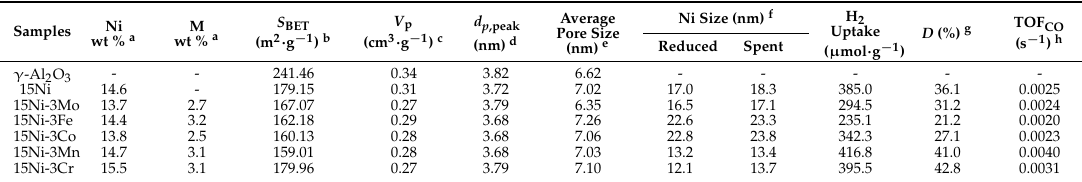
Table 1. Physical and chemical properties of the support and